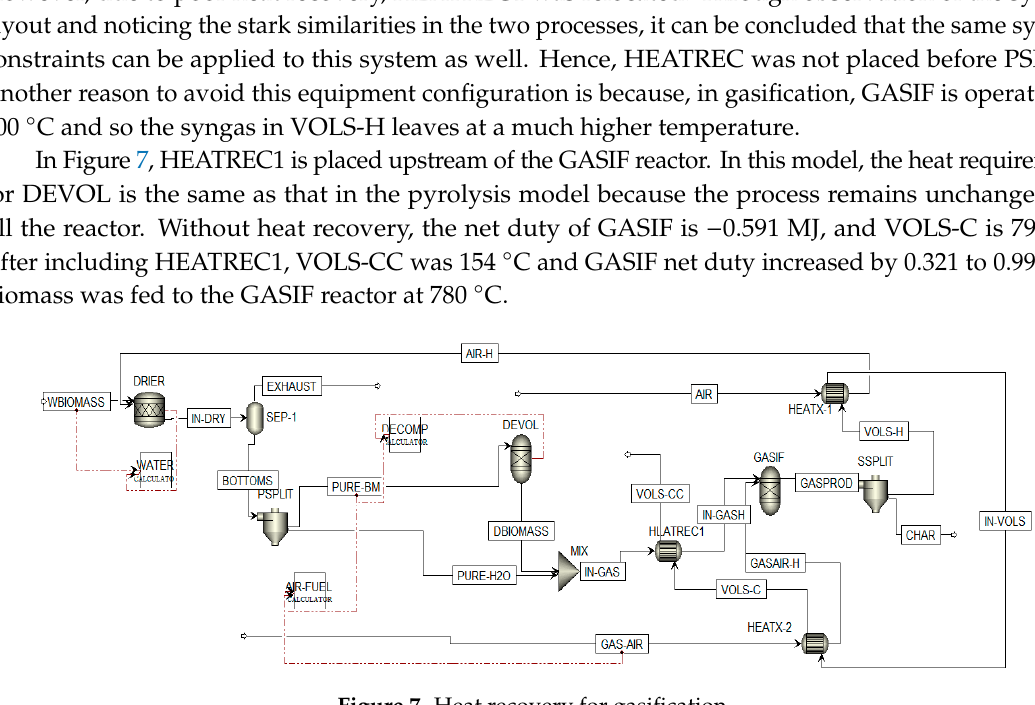
Table 4. Summary of energy requirements in the fermentation model. Equipment